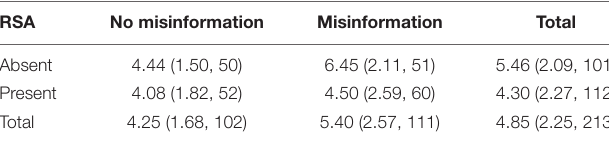
TABLE 1 | Means (SDs, number of participants) of yielding to misinformation across experimental conditions in Experiment 1. RSA No misinformation Misinformation